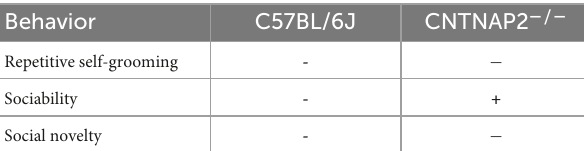
TABLE 1 Summary of behavioral tests and effects after chondroitinase treatment. Behavior